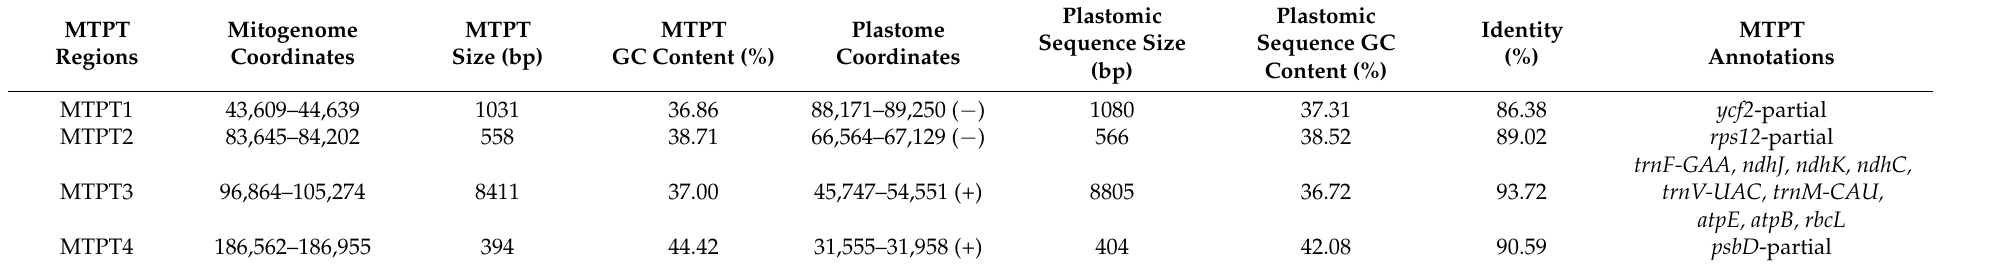
Table 5. Identified MTPTs in S. plumbizincicola